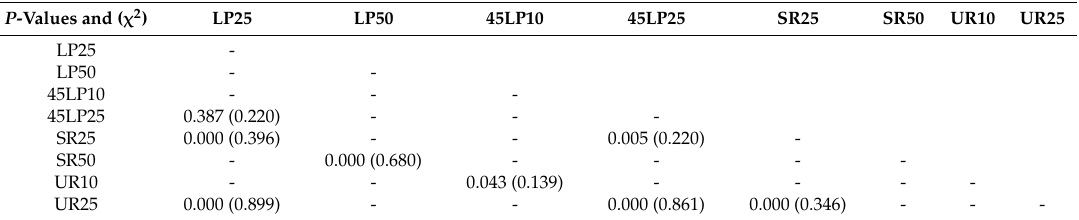
Table A7. P -values and ( χ 2 ) for normalized absolute values of total moments over all subjects—was not analysed.